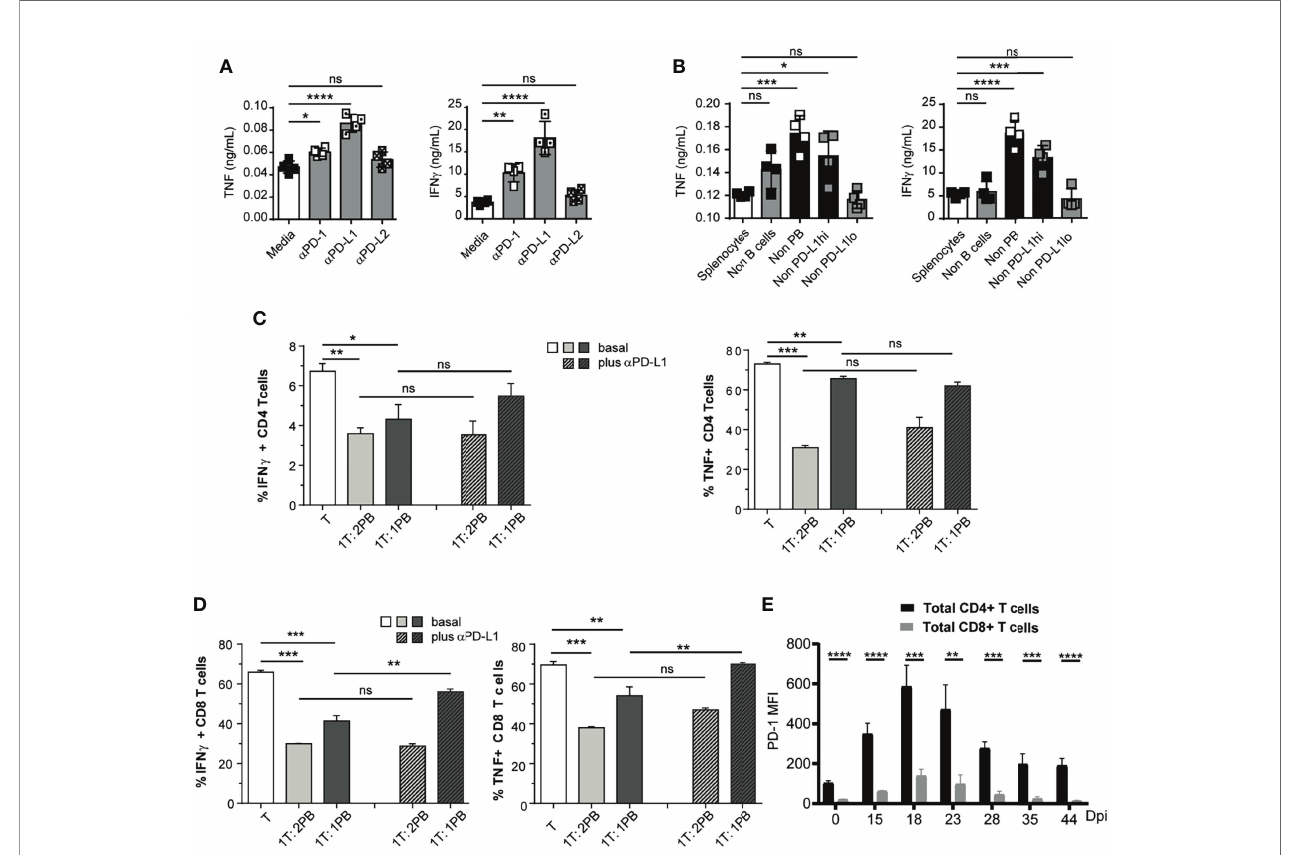
FIGURE 4 | Plasmablasts from T. cruzi -infected mice suppressed CD8+ T cell response via PD-L1. (A) 1 x 10 5 Splenocytes from T. cruzi -infected mice obtained at 14 Dpi were incubated with T. cruzi antigens and cultured for 48h with media, anti-PD-1, anti-PD-L1, or anti-PD-L2. TNF and IFN g concentrations were determined by Elisa in the culture supernatant. (B) 1x 10 5 Non-B (CD19 neg CD138 neg ) cells in a suspension of total splenocytes (non-depleted) from T. cruzi infected mice obtained at 14 Dpi or depleted of B cells (Non-B cells), plasmablasts (Non-PB), PD-L1 hi cells (Non-PD-L1 hi ) or PD-L1 low (Non-PD-L1 lo ) cells were cultured with T. cruzi antigens for 48h. TNF and IFN g concentrations were determined by Elisa in the culture supernatant. (C) Puri fi ed CD4 + and (D) CD8 + ( responder T cell from non-infected mice activated with anti-CD3 plus anti-CD28 were co-cultured with sorted plasmablast from T. cruzi -infected mice obtained at 14 Dpi in 1:1 or 1:2 ratio with for 3 days, in the presence of control antibody (basal) or anti-PD-L1. Bars show the frequency of TNF + and IFN g + CD4 + or CD8 + T cells which were determined by fl ow cytometry. (E) PD-1 expression, determined as MFI by fl ow cytometry, of splenic CD4 + (black) and CD8 + (grey) T cells obtained from T. cruzi -infected mice at different Dpi. Data in (A – D) are representative of two independent experiments. ta are shown as mean ± SD of triplicates cultures. *p<0.05, **p<0.01, ***p<0.001, ****p<0.0001 two-tailed t Test). ns, non signi fi